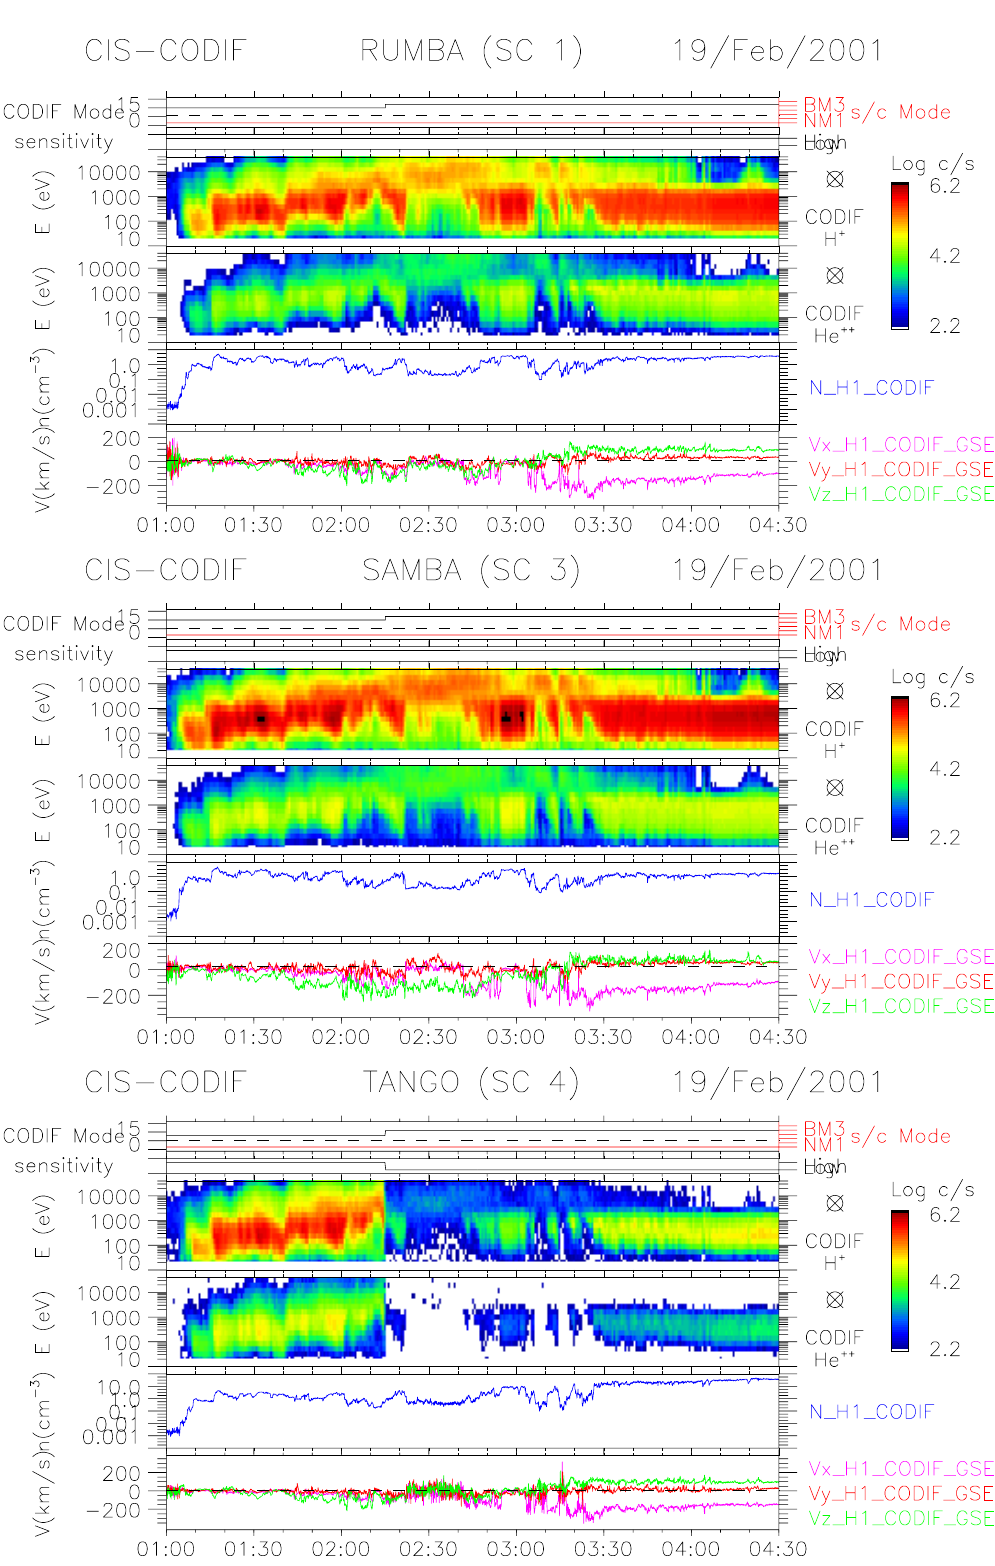
Fig. 34. CODIF measurements on board spacecraft 1 (upper panel), 3 (middle panel) and 4 (lower panel), on 19 February 2001, between 01:00 and 04:30UT. The three panels show CODIF telemetry modes and sensitivities, H + and He ++ energy-time spectrograms integrated over 4 5 , density and GSE velocity